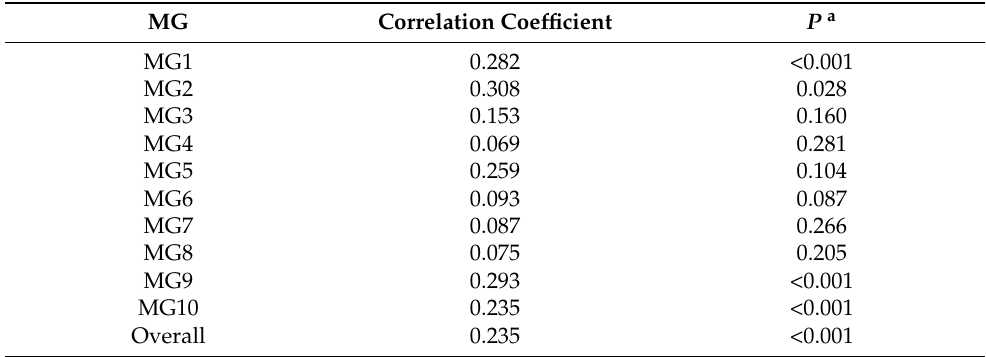
Table 6. Correlation coefficients between the molecular data (SSR) and virulence data within different molecular groups (MG) of Puccinia striiformis f. sp. tritici . MG